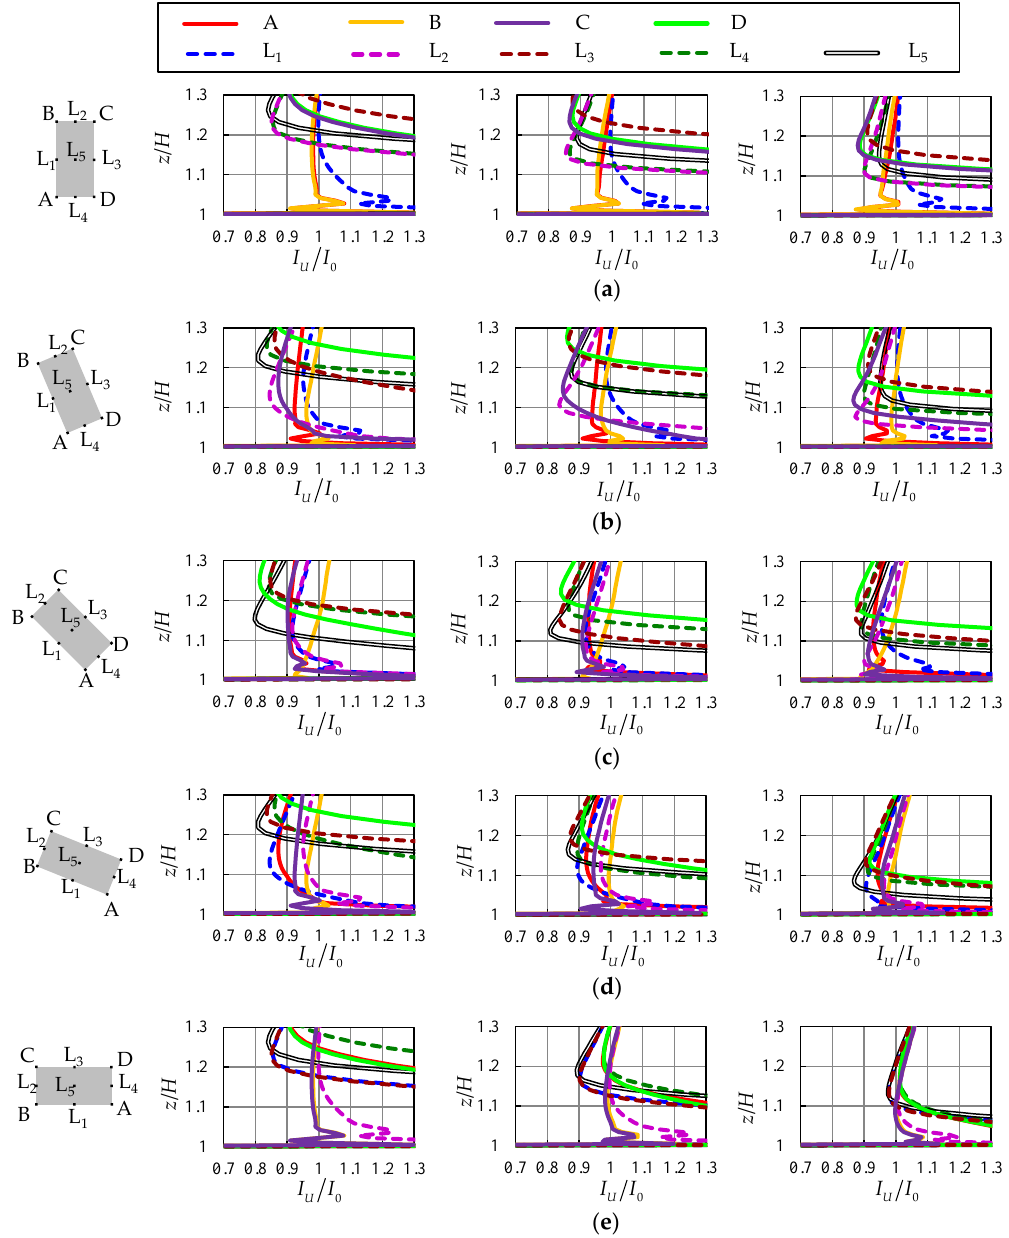
Figure 10. Vertical profiles of turbulence intensity ratios at the representative locations on the roof: HAR = 1.00 ( left ), HAR = 0.50 ( middle ), HAR = 0.25 ( right ). ( a ) α = 0°; ( b ) α = 22.5°; ( c ) α = 45°; ( d ) α = 67.5°; ( e ) α = 90°. In ( d , e ), the graphs of HAR = 1.00 are obtained by editing the results of cases 100_225 and 100_000, respectively, to facilitate the comparison of different HARs.